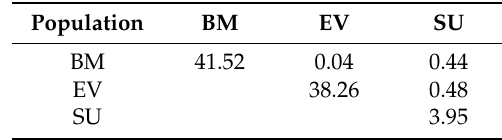
Table 1. Genetic differentiation ( F st ) between three bi-parental (upper triangle elements) and nucleotide diversity ( π ) within these populations (diagonal elements).